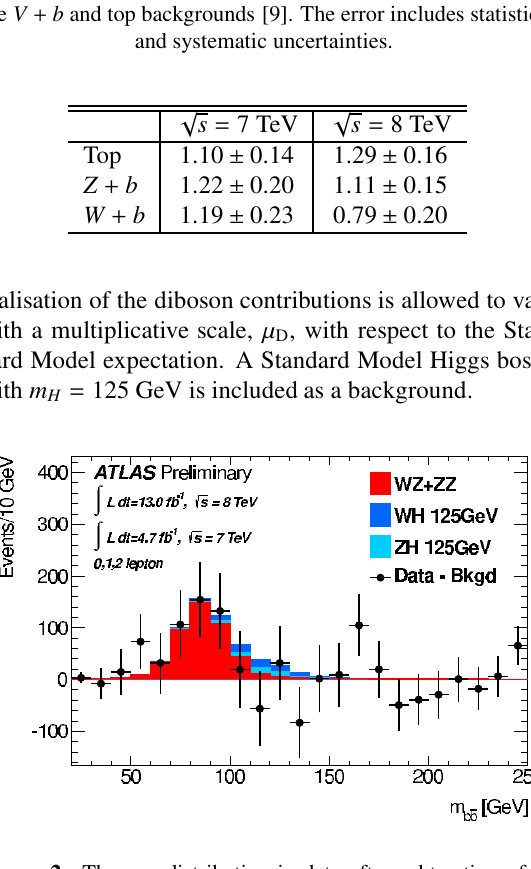
Figure 2. The m distribution in data after subtraction of all b ¯ b backgrounds except diboson processes including SM Higgs bo- son from WH and ZH associated production [9]. The MC back- grounds are normalised according to the results of the global fit. Only statistical uncertainties are shown.